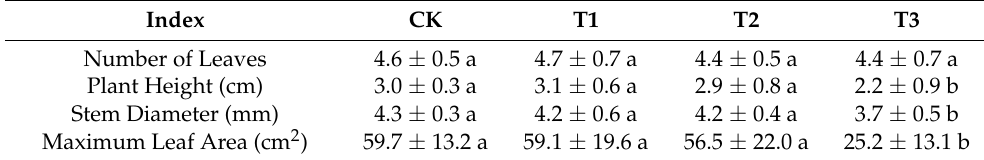
Table 1. Agronomic characteristics of tobacco under different treatments.